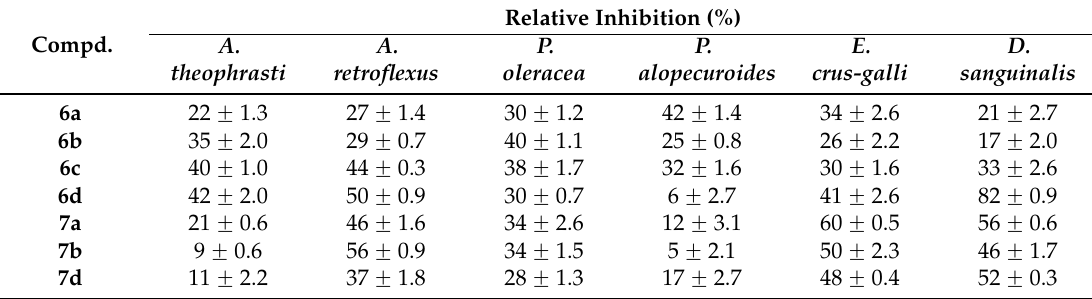
Table 3. Herbicidal activities of compounds in greenhouse conditions